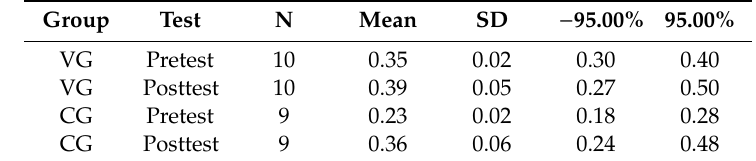
Table 7. Average fixation duration (seconds), mean values, standard deviations ( SD ), and confidence intervals.